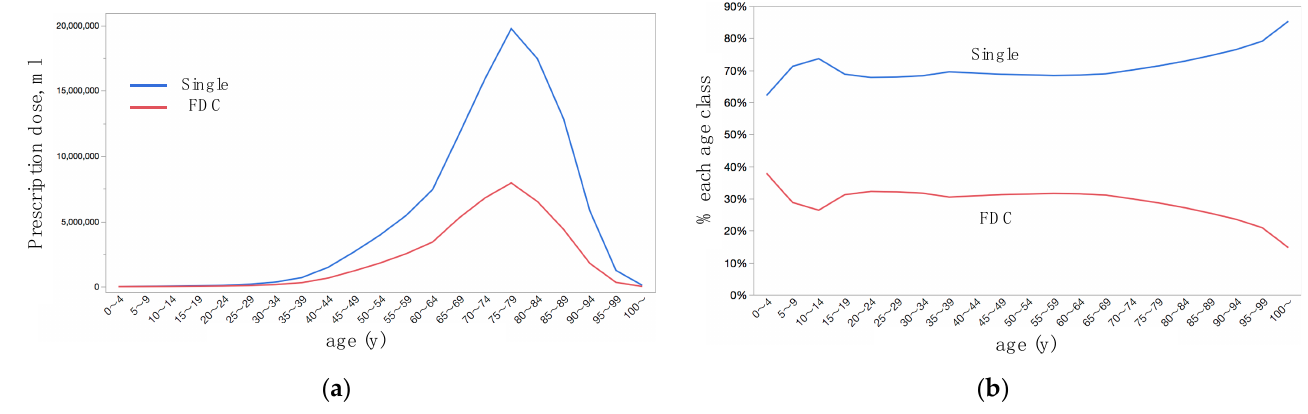
Figure 2. Age-dependent distributions of prescription dose of topical anti-glaucoma medications stratified by sex. ( a ) Actual prescription dose. ( b ) Percentage of prescription dose in each age class.